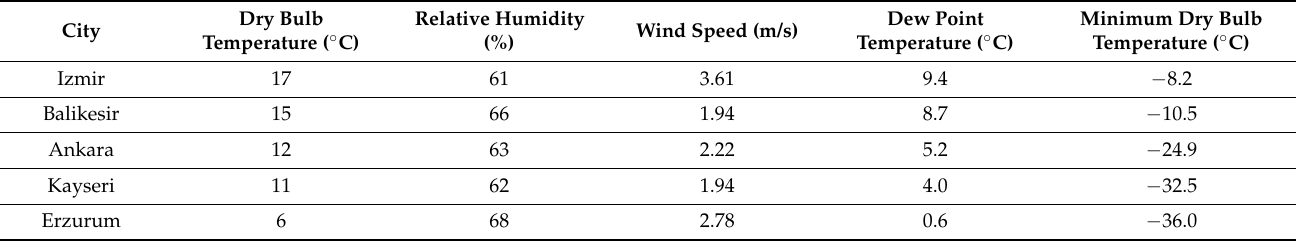
Table 1. The annual average meteorological values